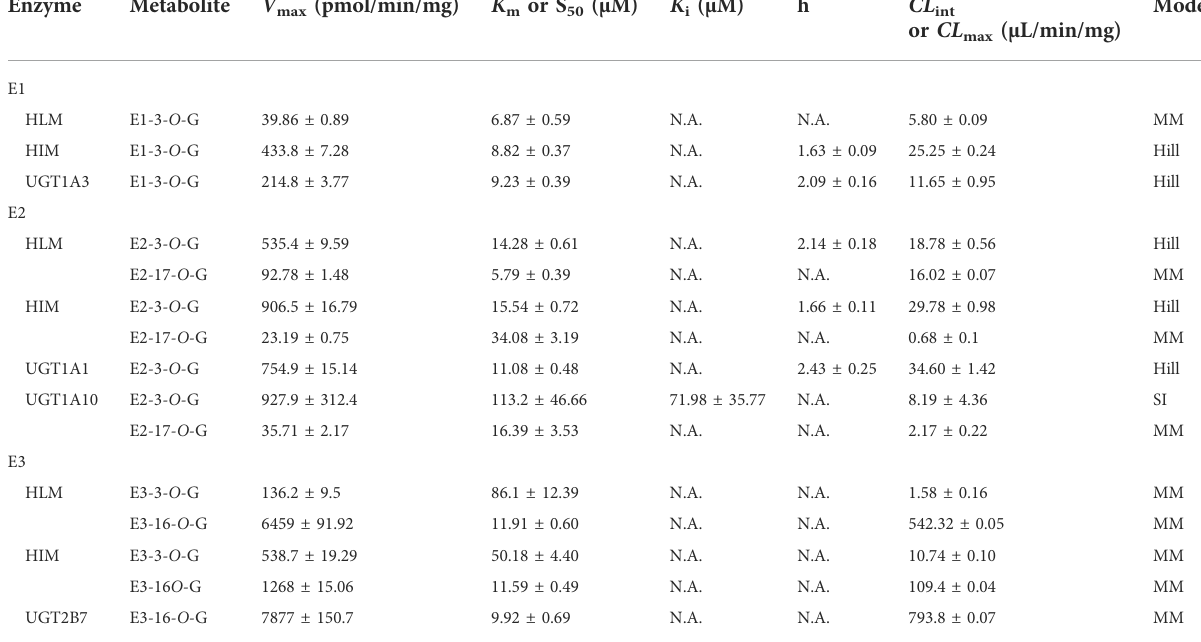
TABLE 1 Kinetic parameters of E1, E2, and E3 by HLM, HIM, and expressed UGT enzymes (Mean ± SD). All experiments were performed in triplicate ( n = 3).